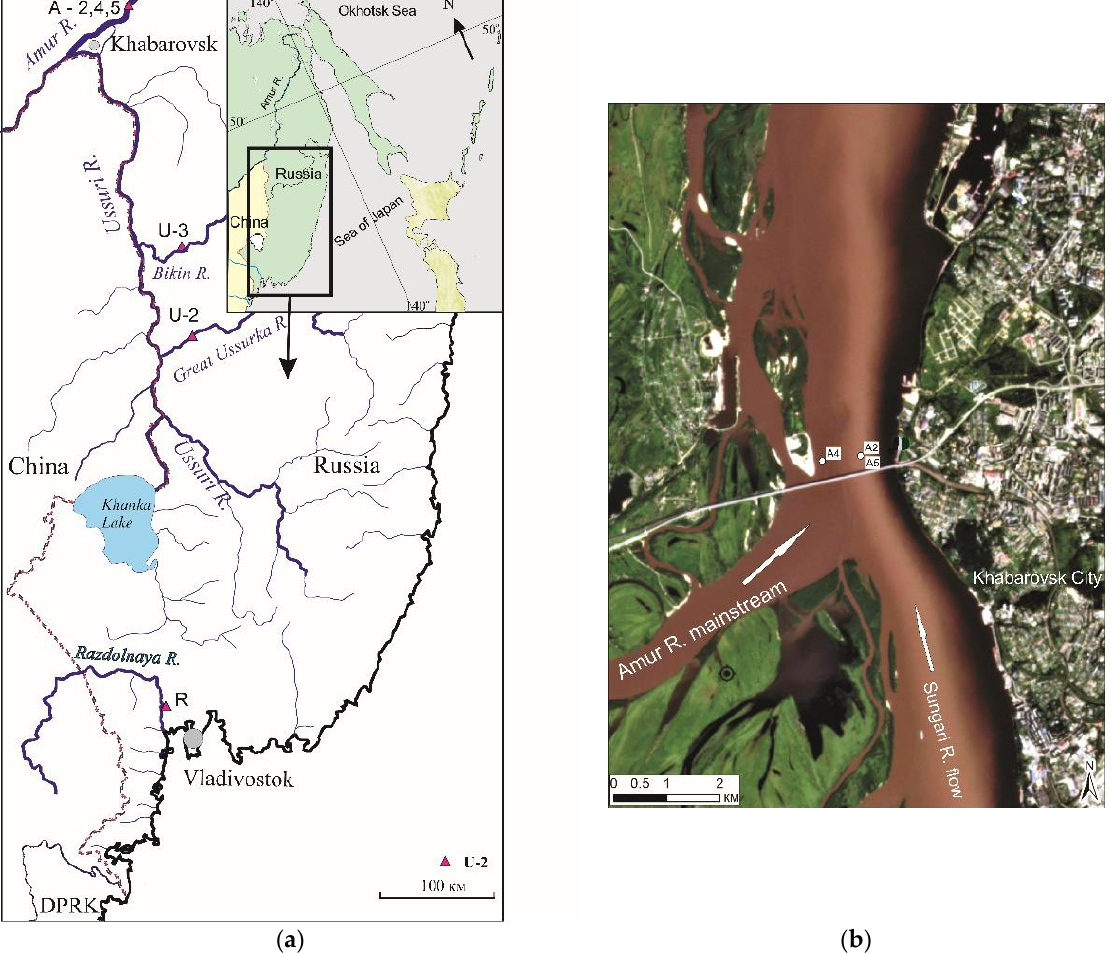
Figure 1. ( a ) Scheme of the study area; triangles are the location of the sampling points, and the numbers of samples are listed in Table 1. ( b ) Sampling 21 August 2020 across the Amur R. A-4 within the mainstream, A-5 (and A-2 in 27 February 2020) within the more turbid flow of Sungari